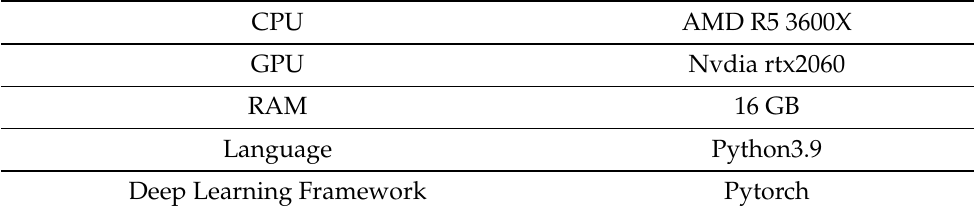
Table 1. Experimental environment.